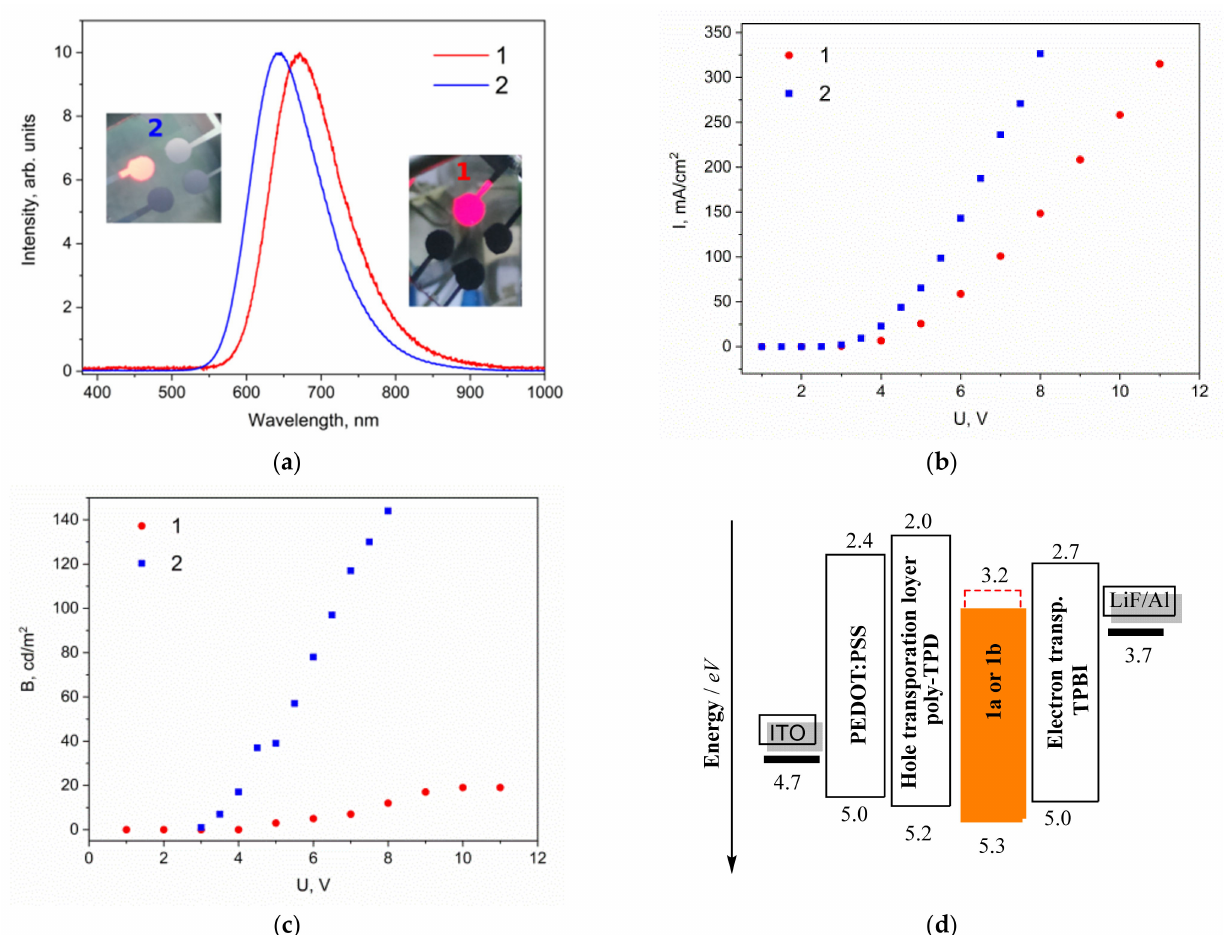
Figure 7. Electroluminescence spectra at 12 V ( a ), density-voltage ( b ), and luminance-voltage ( c ) plots for structures 1 and 2. The schematic diagram of the structures of OLEDs and the energy levels of the materials ( d